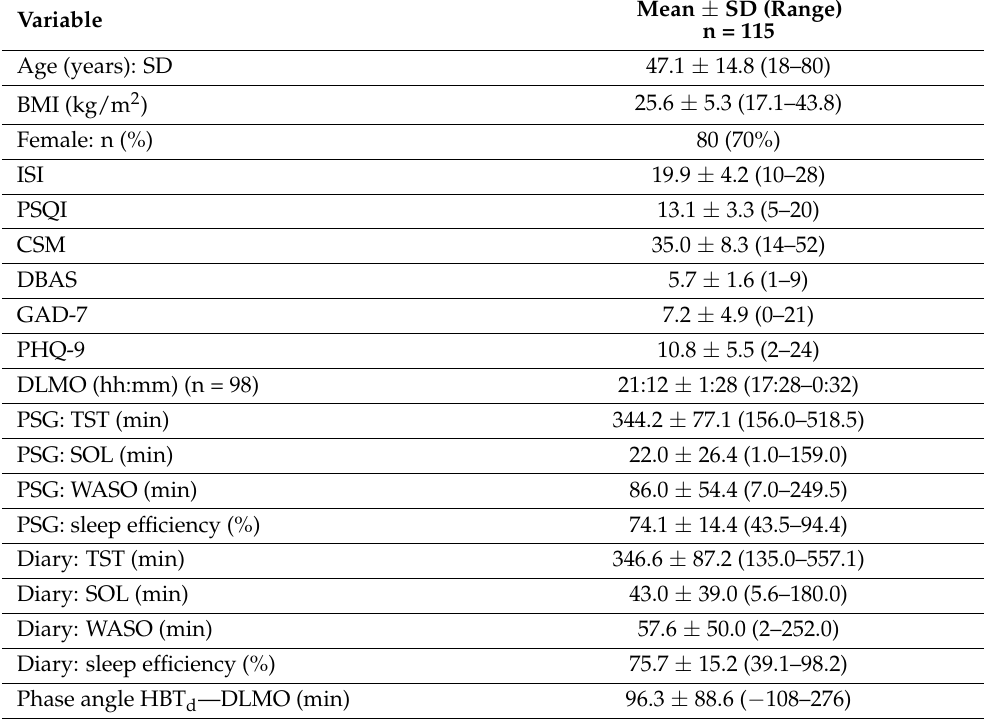
Table 1. Demographic, sleep and clinical measures of the participants. Key: ISI—Insomnia severity index; PSQI—Pittsburgh sleep quality index; CSM—Composite Scale of